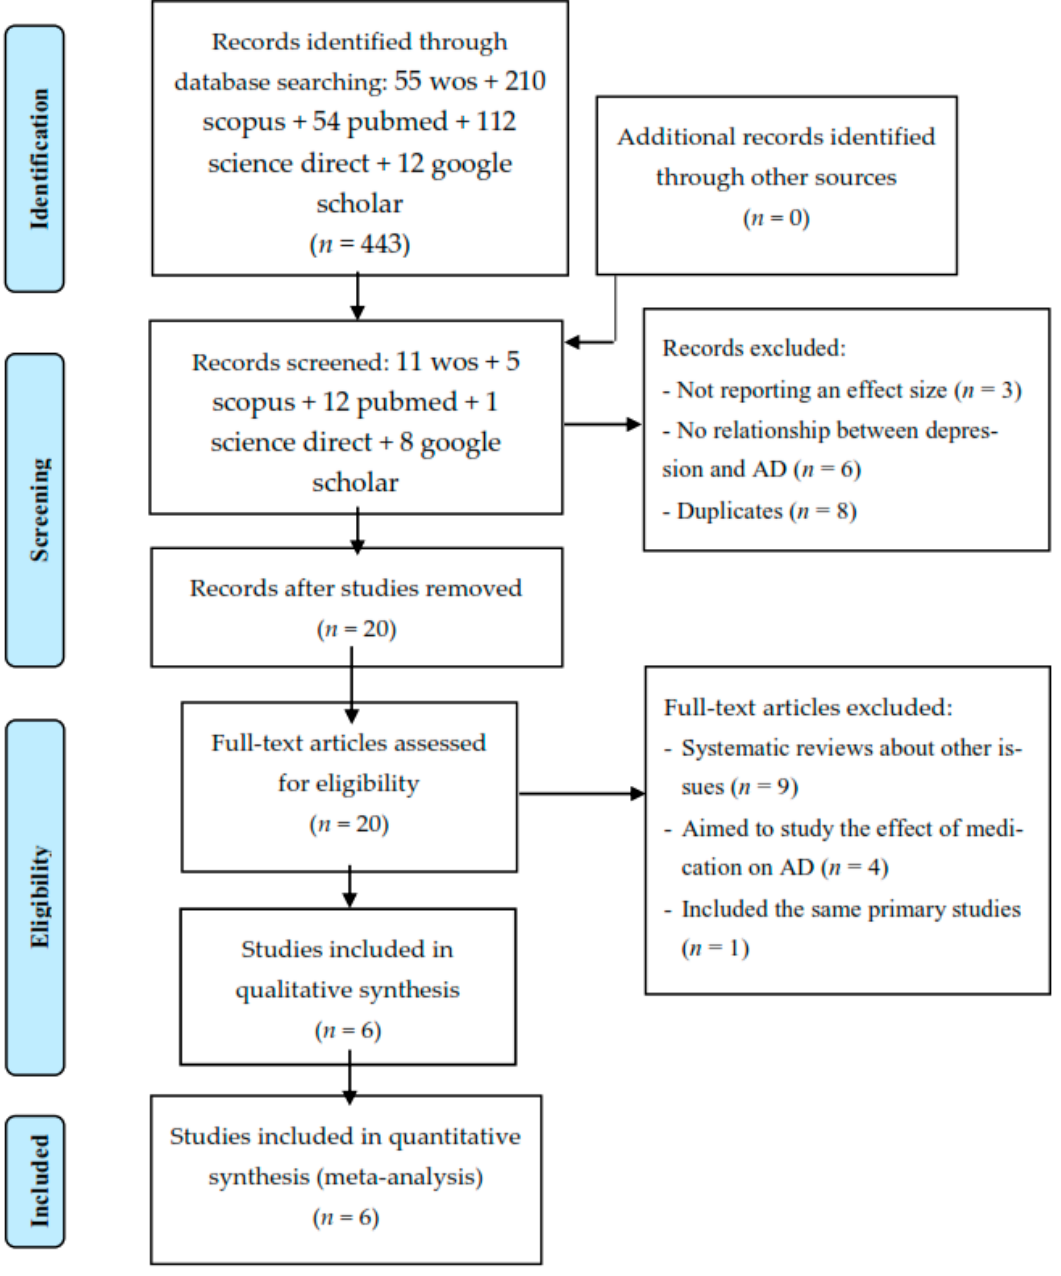
Figure 1. Flow chart depicting the selection of articles for our meta-analysis. Note: AD: alzheimer’s disease; n: number of studies.